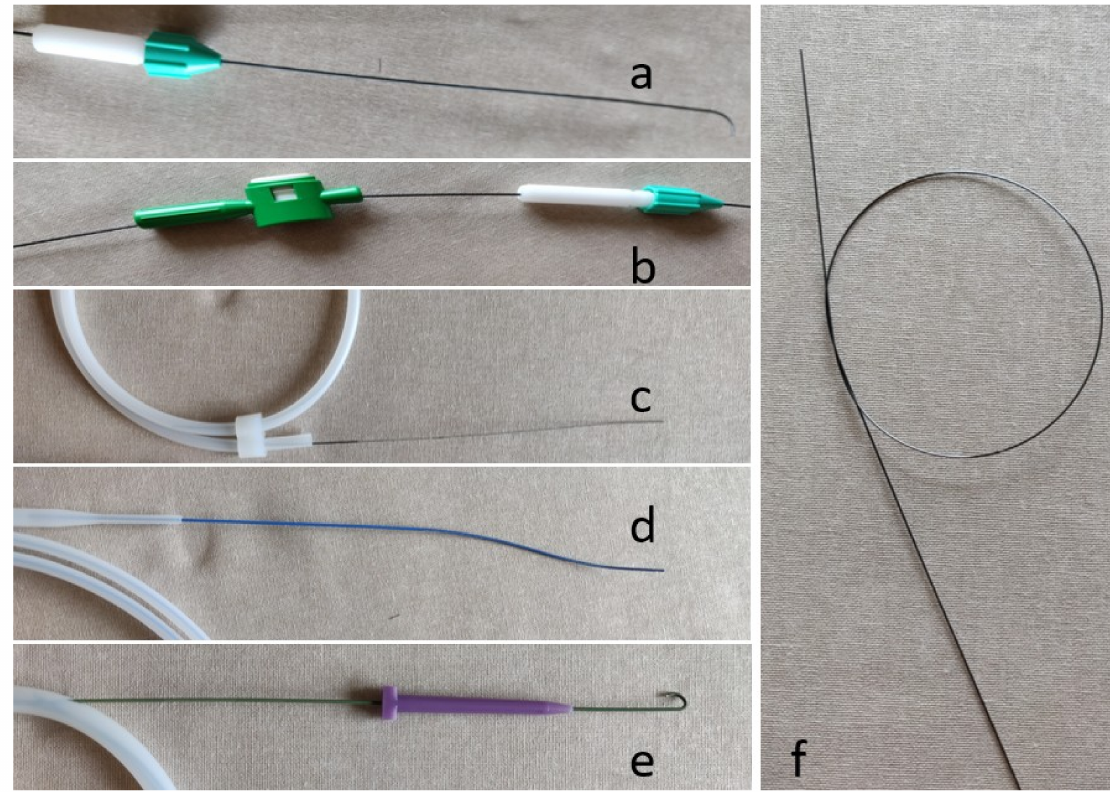
Figure 3. Di ff erent types of wires and torque devices. (a) Hydrophilic wire with a mounted torque device, (b) two di ff erent torque devices mounted on a hydrophilic wire, (c) access wire with a floppy tip, (d) Amplatz wire, (e) J-shaped Rosen wire, and (f) access wire with a coiled end to facilitate torquing the wire without the need for a torque